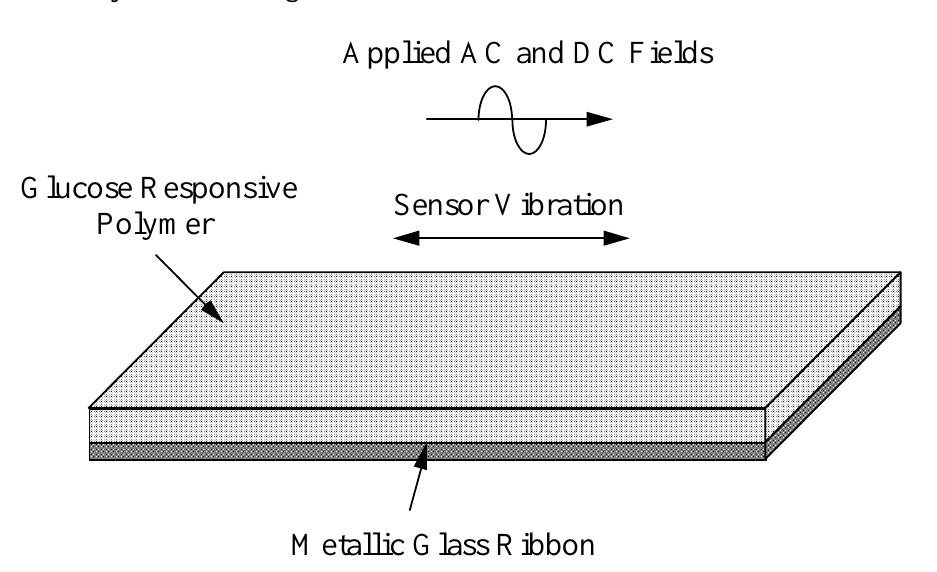
Figure 2. The magnetoelastic glucose sensor is made of an amorphous metallic glass ribbon coated with a thin layer of mass changing glucose responsive